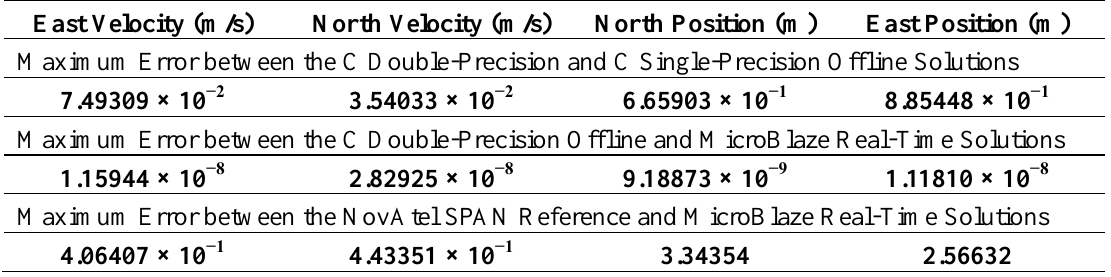
Table 4. Maximum Error in the East Velocity, North Velocity, North and East Positions over Mobile Robot Trajectory